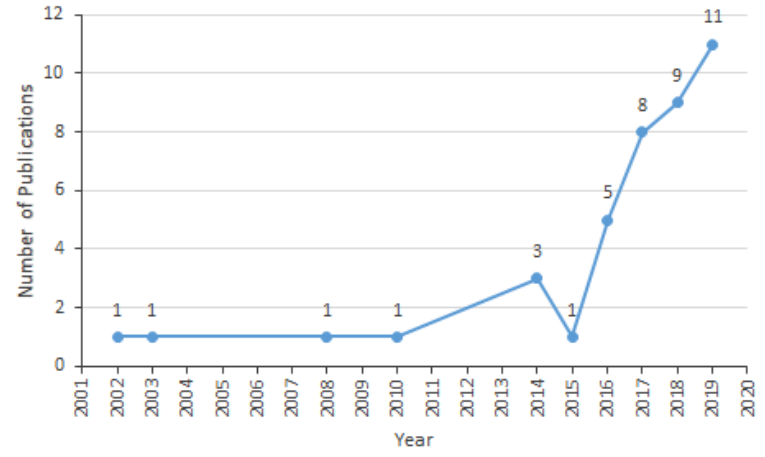
Figure 2. The evolution of the